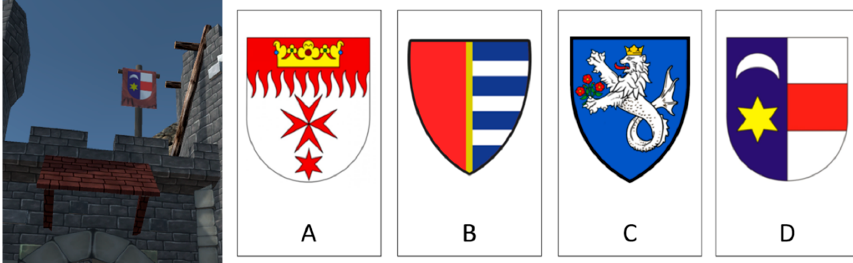
Figure 4. Example of an object visual recognition test item–coat of arms on a flag. A, B, C: distractor objects; D: correct object.